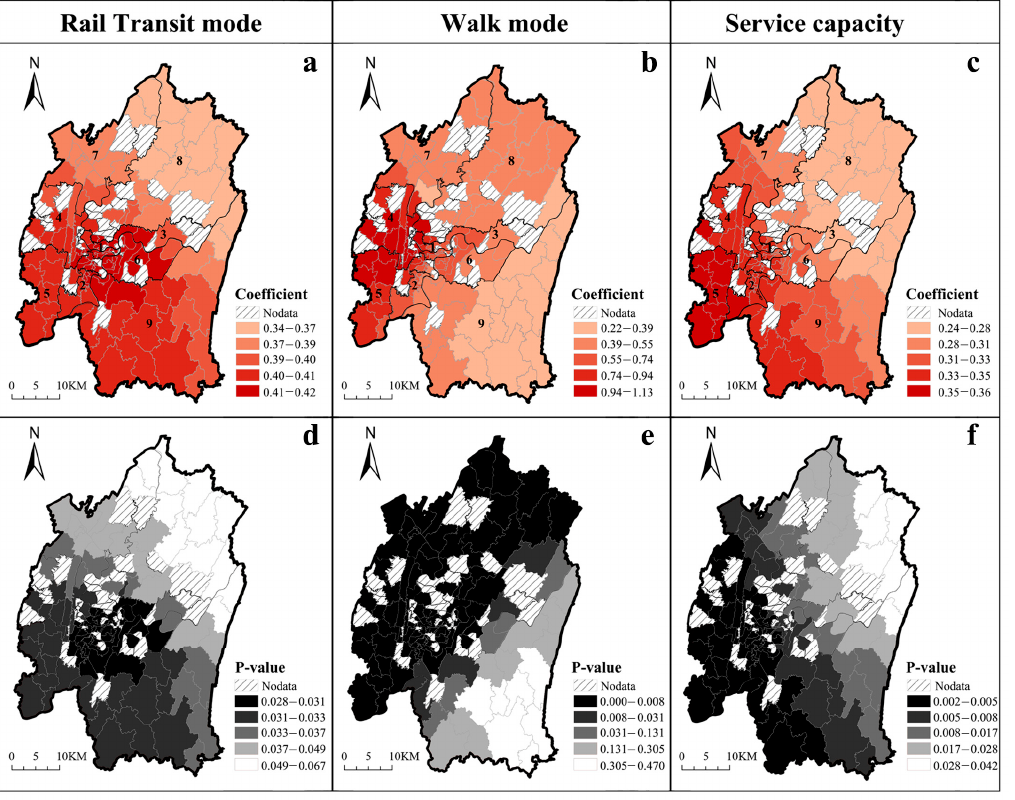
Figure 10. Spatial distribution of regression coefficients and significance.